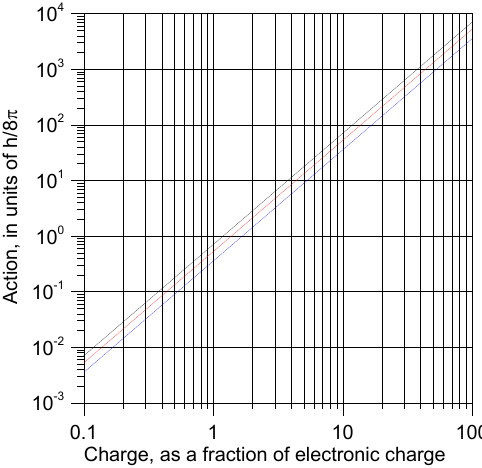
Figure 10. The value of the maximum observed in Figures 8 and 9 as a function of the charge associated with the current.